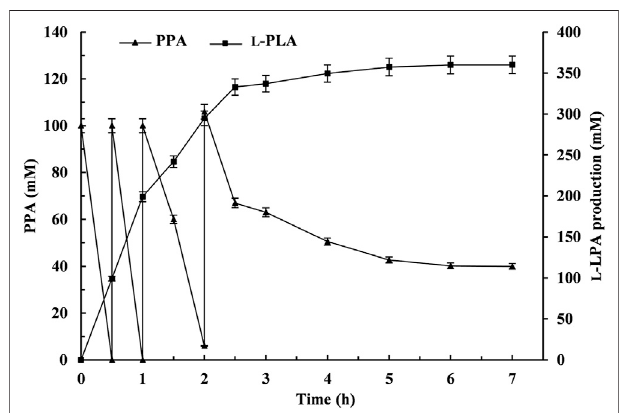
FIGURE. 7 | Time course of the fed-batch production of L-phenyllactic acid (L-PLA) by coupling L- Lc LDH1 Q88A/I229A (Pp) with Ls GDH D225C in vitro . ▲ , phenylpyruvic acid concentration; ■ , L-PLA production. Means and standard deviations of triplicate experiments are